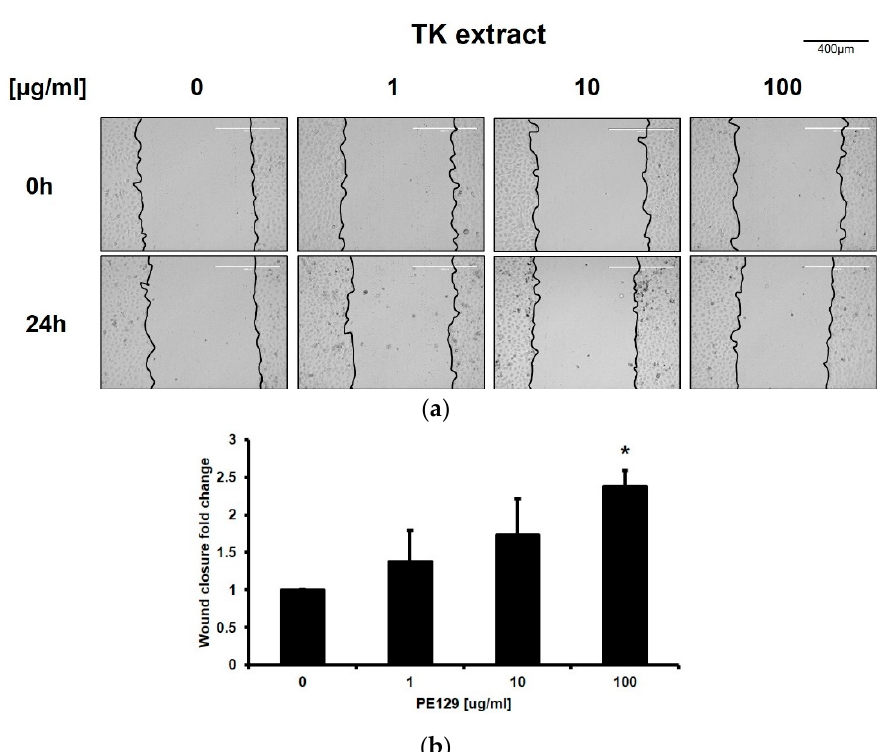
Figure 2. TK extract promoted the in vitro wound healing of HaCaT cells. HaCaT cells were cultured in a 6-well plate, scratched, and treated with the indicated concentration of TK extract. After 24 h, the scratched area was measured and compared. ( a ) The results were imaged to show scratched wound healing. ( b ) The fold change graph of ( a ). (*: p < 0.05.)